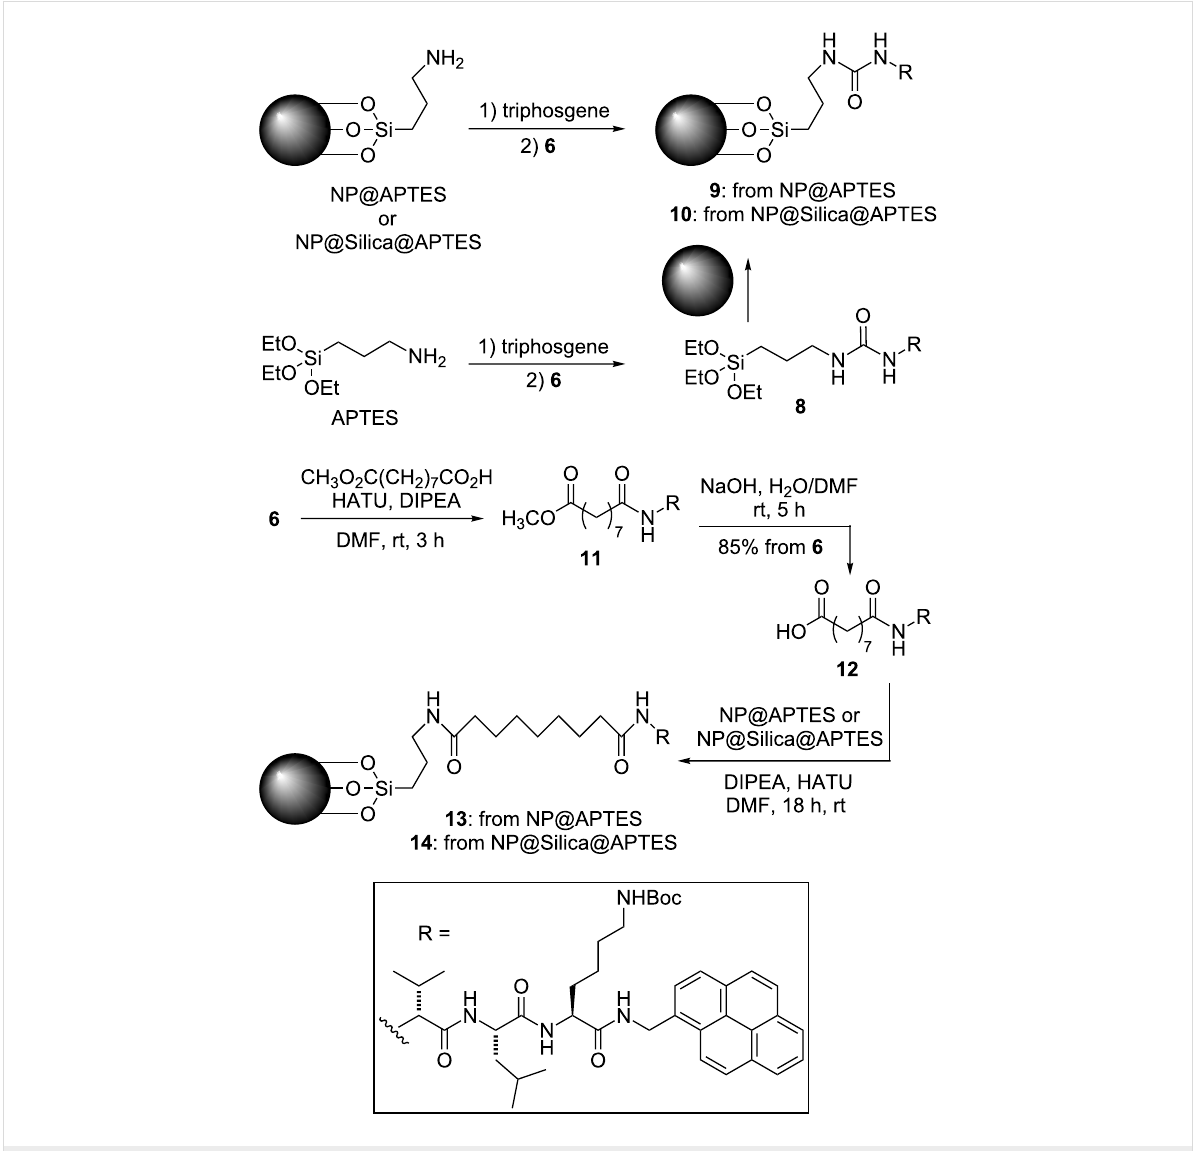
Scheme 2: Strategies employed for linking tripeptide 6 to magnetic